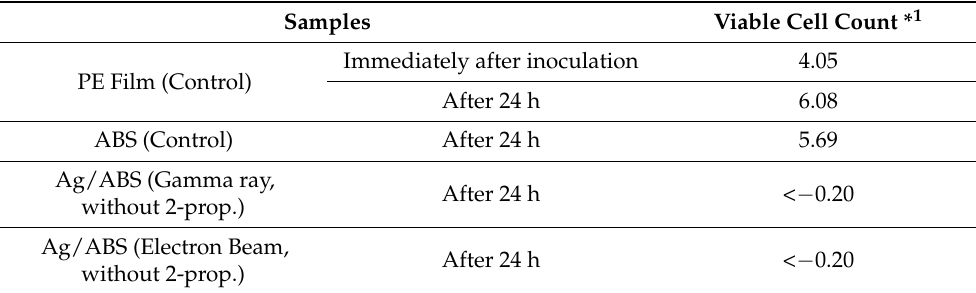
Table 2. Antibacterial activity of Ag/ABS samples against E .c oli . Samples